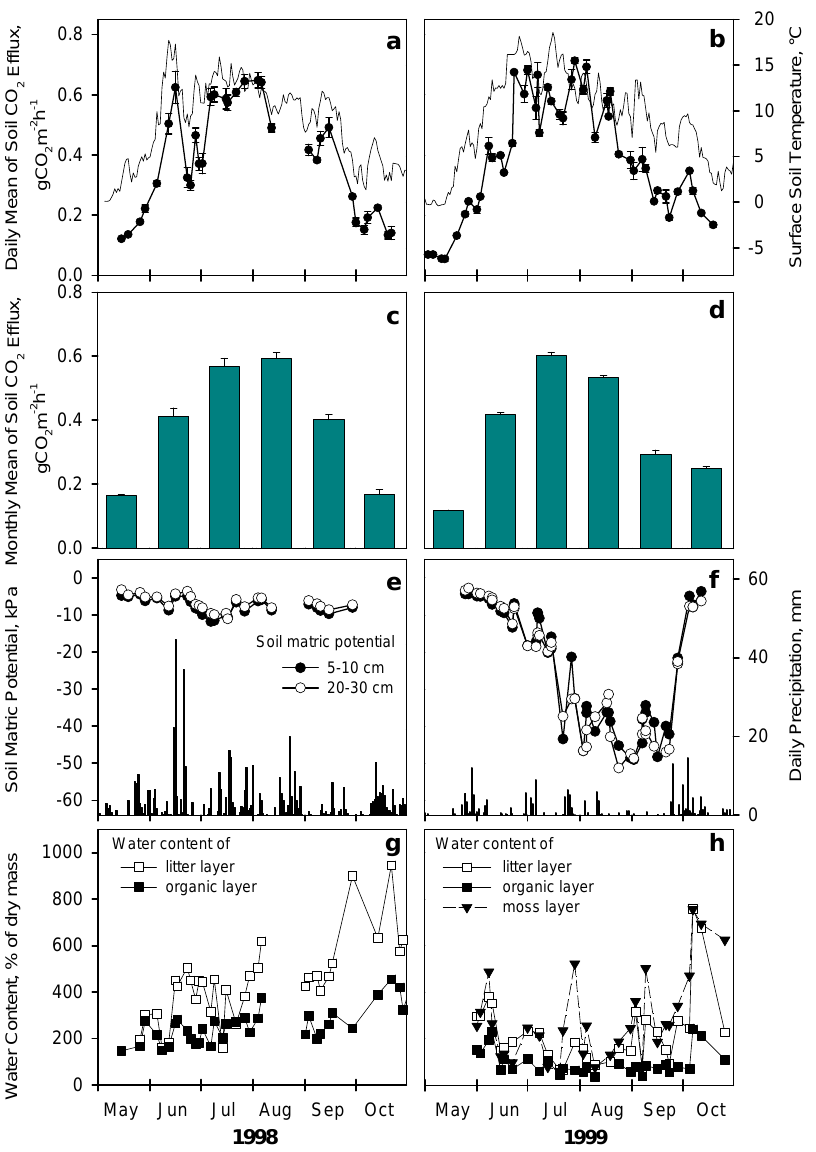
Fig. 1. (a, b) Daily means of soil CO 2 efflux in May–October 1998 ( a ) and 1999 ( b ) shown with black circles, standard error bars presenting variation between three plots. Each plot represents an average of 10 measurement points. Soil temperature at 1–2cm in the organic i.e. humus layer is depicted with solid black line. (c, d) Monthly means of soil CO 2 efflux in May–October 1998 and 1999, standard error bars presenting variation between three plots. (e, f) Average soil matric potential at 5–10cm depth (open circles) and at 20–30cm depth (black circles) and daily precipitation depicted with black bars in 1998 ( e ) and 1999 ( f ). (g, h) Gravimetric water content of litter (open squares), organic i.e. humus (black squares) and moss layer (triangles) in 1998 ( e ) and 1999 ( f